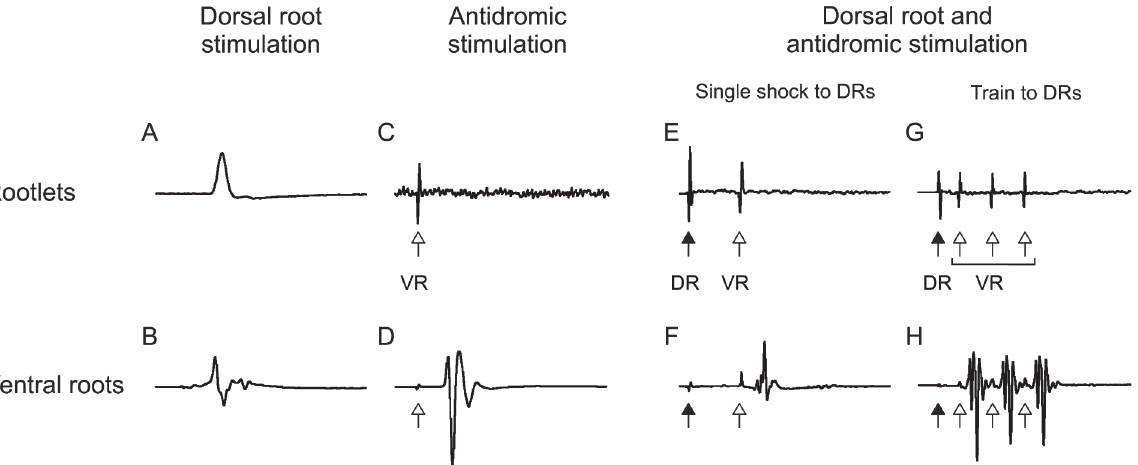
Fig 3. Antidromic action potential invasion of L4 and L5 motor neurons, evoked by stimulation in the sciatic nerve of their regenerating axons, does not lead to firing of nearby motor neurons. This is true either when the antidromic stimulation is acting alone (C,D; VR = ventral root) or when it is combined with conditioning facilitation evoked by stimulation of the dorsal roots (E,F,G,H; DR = dorsal root). For positions of stimulating and recording electrodes refer to Fig 2 and its legend. All traces are averages of 5 – 10 responses; stimulus artifacts to the dorsal roots are marked by filled head arrows, while those to the sciatic nerve by open head arrows. (A and B) Mono- and polysynaptic compound action potentials of lumbar motor neurons, recorded from cut ventral rootlets (A, monophasic record), or from the remaining intact ventral root axons (B, diphasic record); in both records the stimulus (single shock to the dorsal roots) occurs slightly before the sweep onset (~0.5 ms). (C and D) Although the action potentials evoked by single shocks to the sciatic nerve are, as expected, conducted antidromically to the spinal cord (record of the retrograde incoming volley in D), they fail to excite L4 and L5 motor neurons whose axons are not stimulated and instead recorded monophasically from diverted ventral rootlets as shown in C. Records A,B,C,D are from the same rat 5 days after sciatic nerve crush. (E,F,G,H) The antidromic (test) supramaximal stimulation of the sciatic nerve is combined with conditioning stimulation of the dorsal roots (at strength immediately below threshold for the appearance of reflex VR responses), single or repetitive and at variable intervals as specified in Results. (E,F) A single test shock to the sciatic nerve, following after 5 ms a conditioning single shock to the DRs, evokes an antidromic incoming volley in F, but no visible response after the test stimulus artifact in the rootlets record in E; records E,F are from a rat 17 days after nerve crush. (G,H) A train of 5 conditioning stimuli at 100 Hz to the DRs, precedes by 2 ms a train of three test stimuli at 300 Hz to the sciatic nerve, eliciting three incoming volleys in the ventral roots as seen in H, but no response in the rootlets monophasic record of G (the first stimulus artifact visible in the sweeps G and H, is the last of the five conditioning single shocks to the DRs); records G,H are from a rat 18 days after nerve crush. Voltage calibrations: 750 μ V (A,B,D); 50 μ V (C,E,G); 150 μ V (F,H). Time calibrations: 2 ms (A,B,C,D); 4 ms (E,F,G,H).